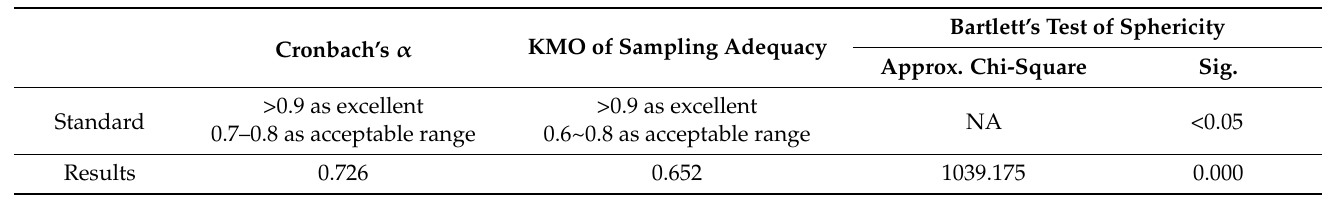
Table 4. The reliability and validity results.